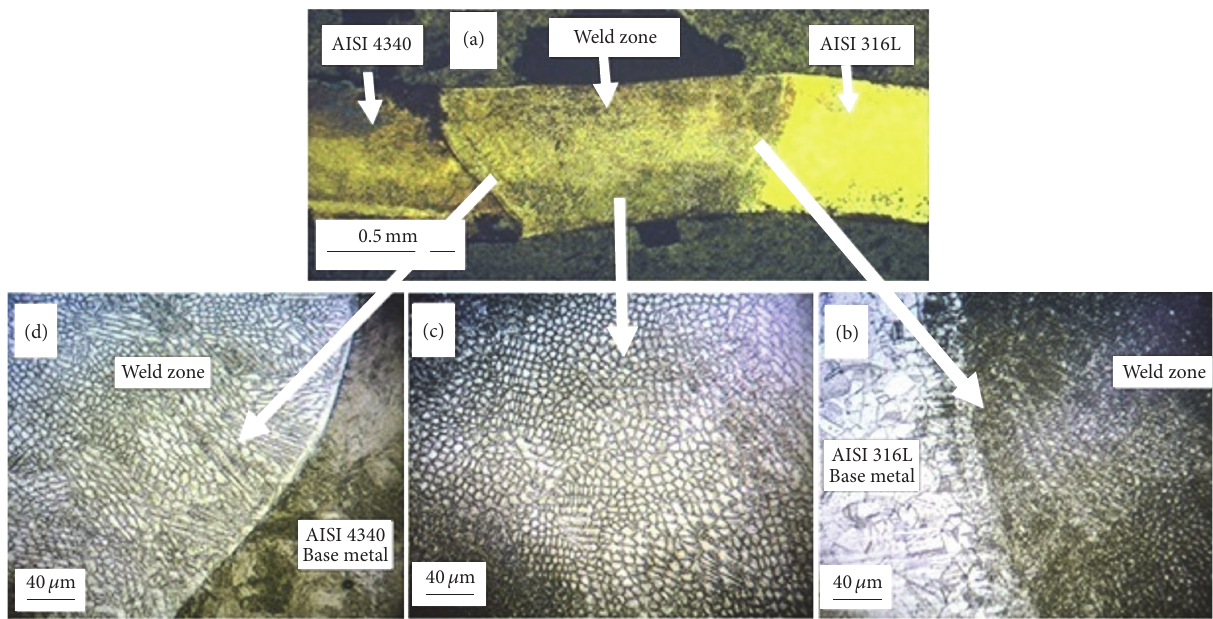
Figure 12: The weld microstructure for sample number 3: (a) weld macrograph; (b) near AISI 316L; (c) center of weld; (d) near AISI 4340.